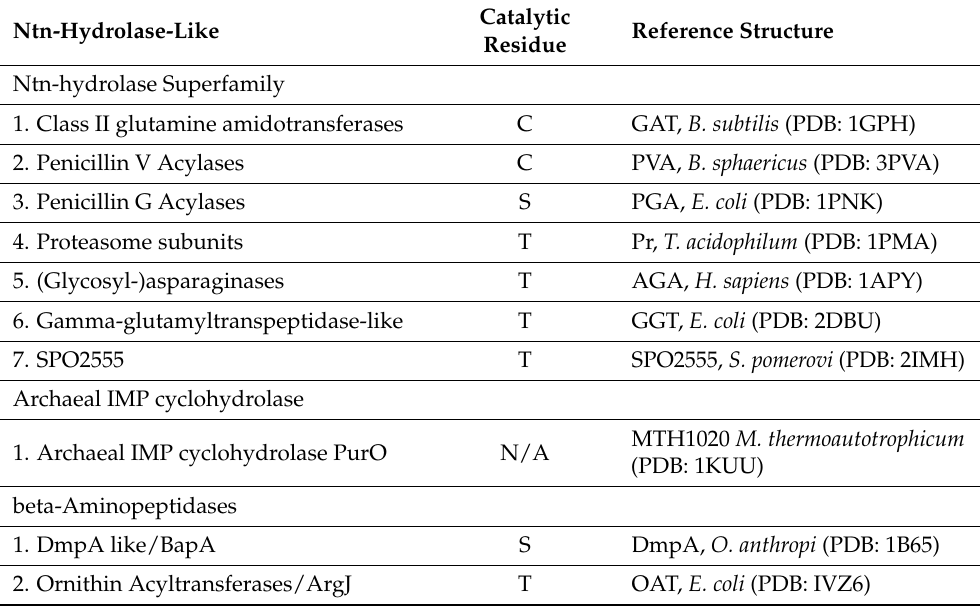
Table 1. Ntn-hydrolase-like families with subfamilies according to SCOPe. The catalytic active N-terminal nucleophilic amino acid (catalytic residue) is indicated in the one letter code.